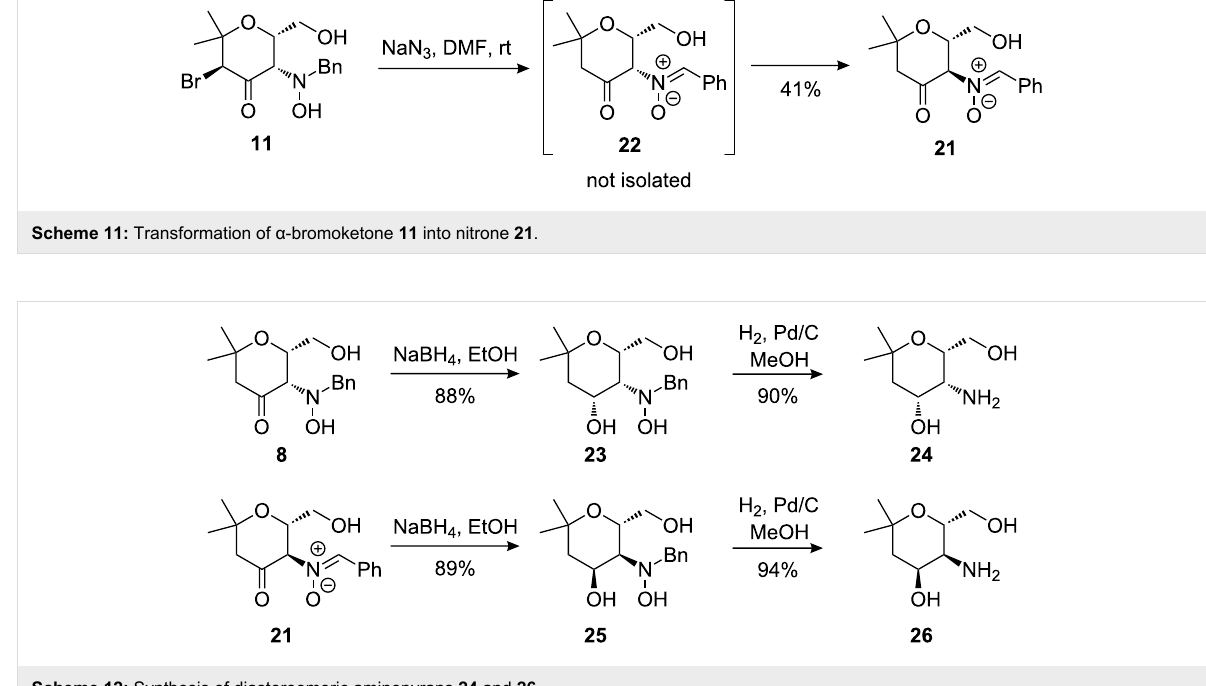
Scheme 12: Synthesis of diastereomeric aminopyrans 24 and 26 .